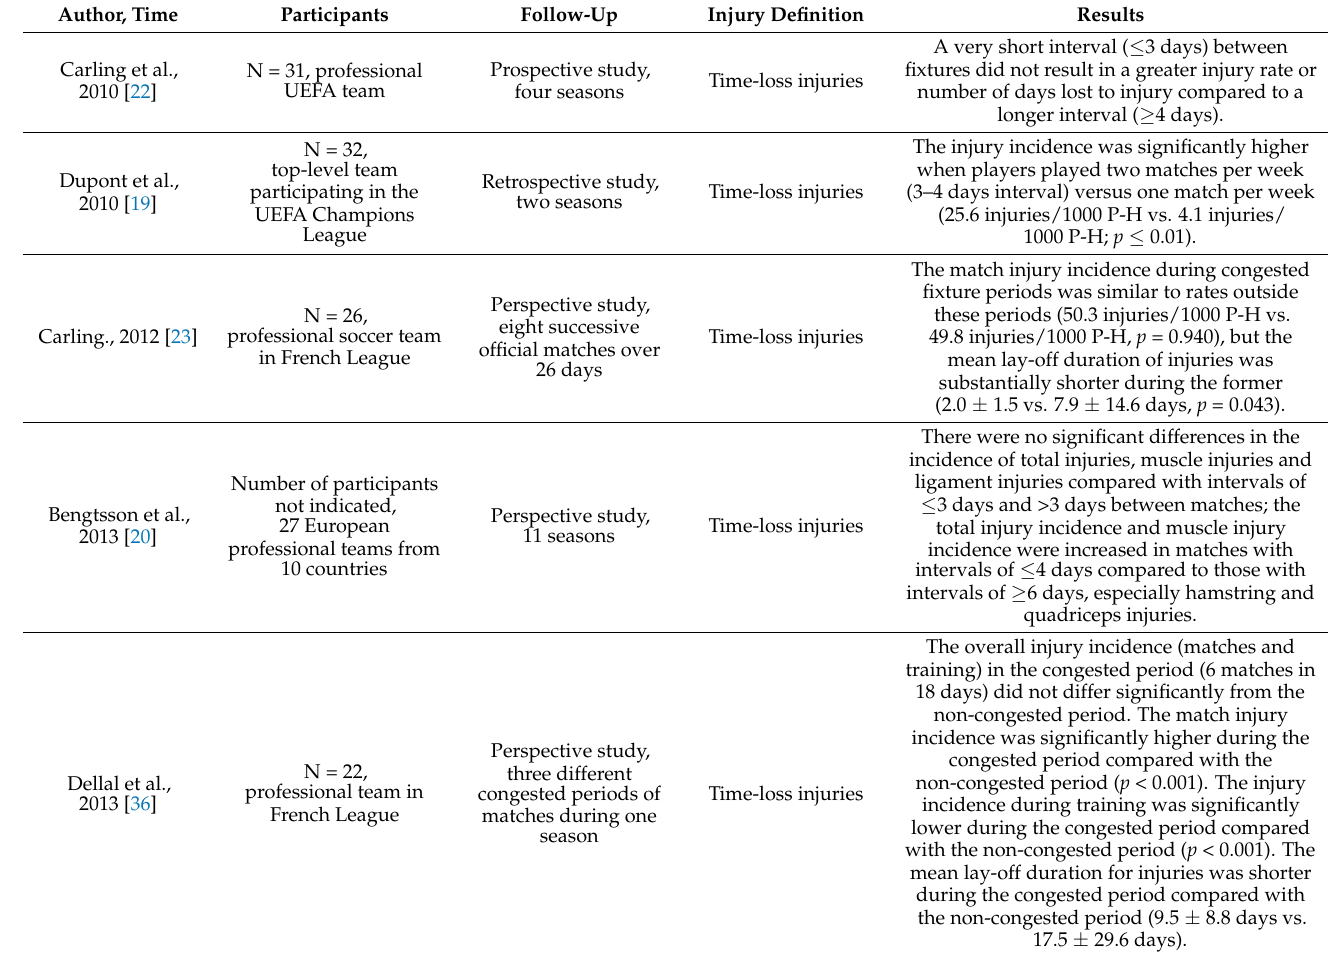
Table 2. Research literature on the relationship between fixture congestion and injury